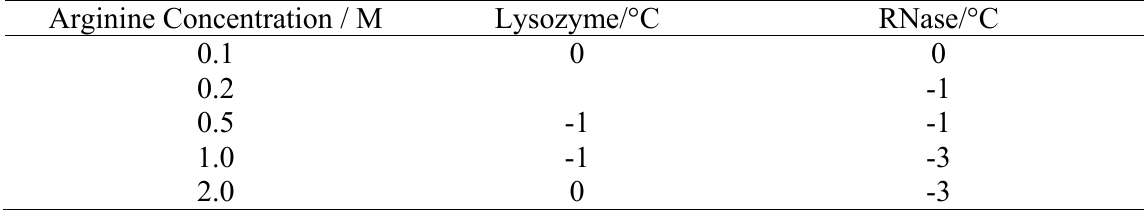
Table 2. Change in melting